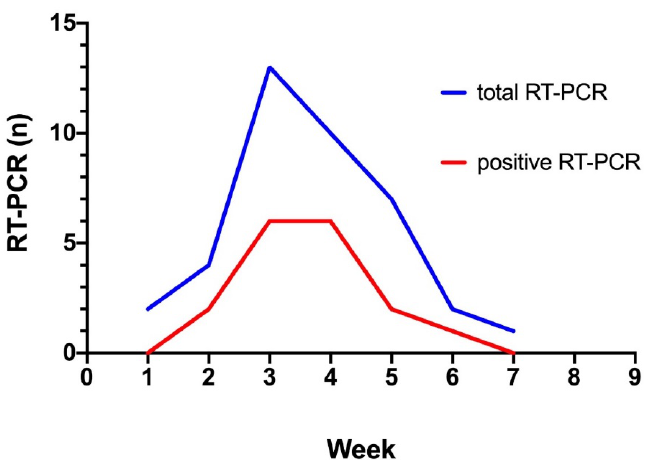
Figure 2. Evolution of the number of reverse-transcriptase polymerase chain reaction (RT-PCRs) testing for SARS-CoV-2 performed between March 12 and April 24 2020. The blue line represents the evolution of the number of RT-PCR performed between week 1 and 8. The red line represents the evolution of the number of positive RT-PCR sent during week 1 and 8. Table 1. Patients baseline characteristics.